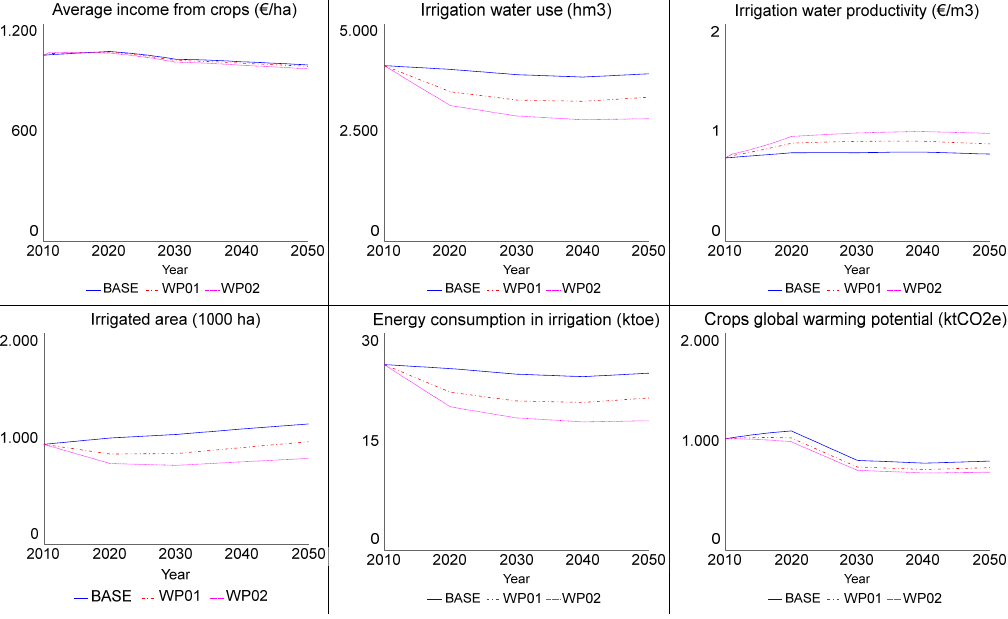
Figure 7. System dynamics modelling (SDM) results. Source: our own elaboration.